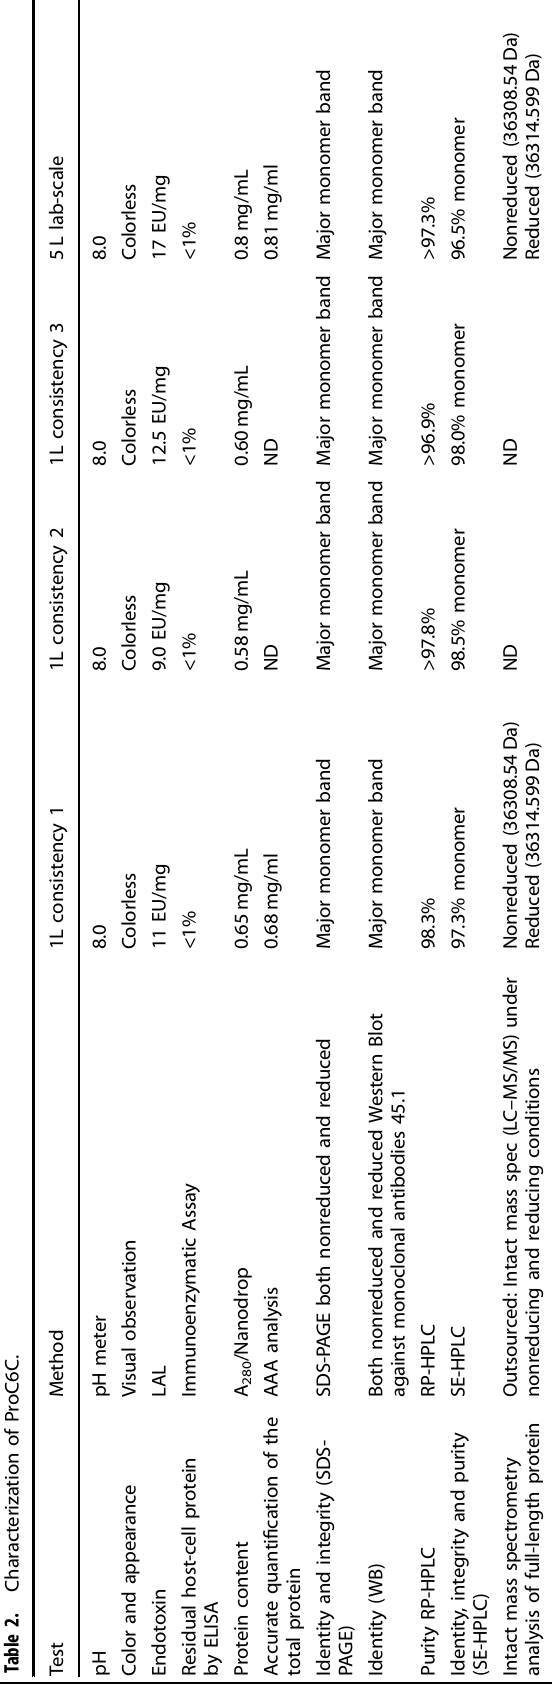
parallel. Raw image fi les for gels and Western blot images are provided in Supplementary materials (Supplementary Figure S4-S7). Production of ProC6C at the bench